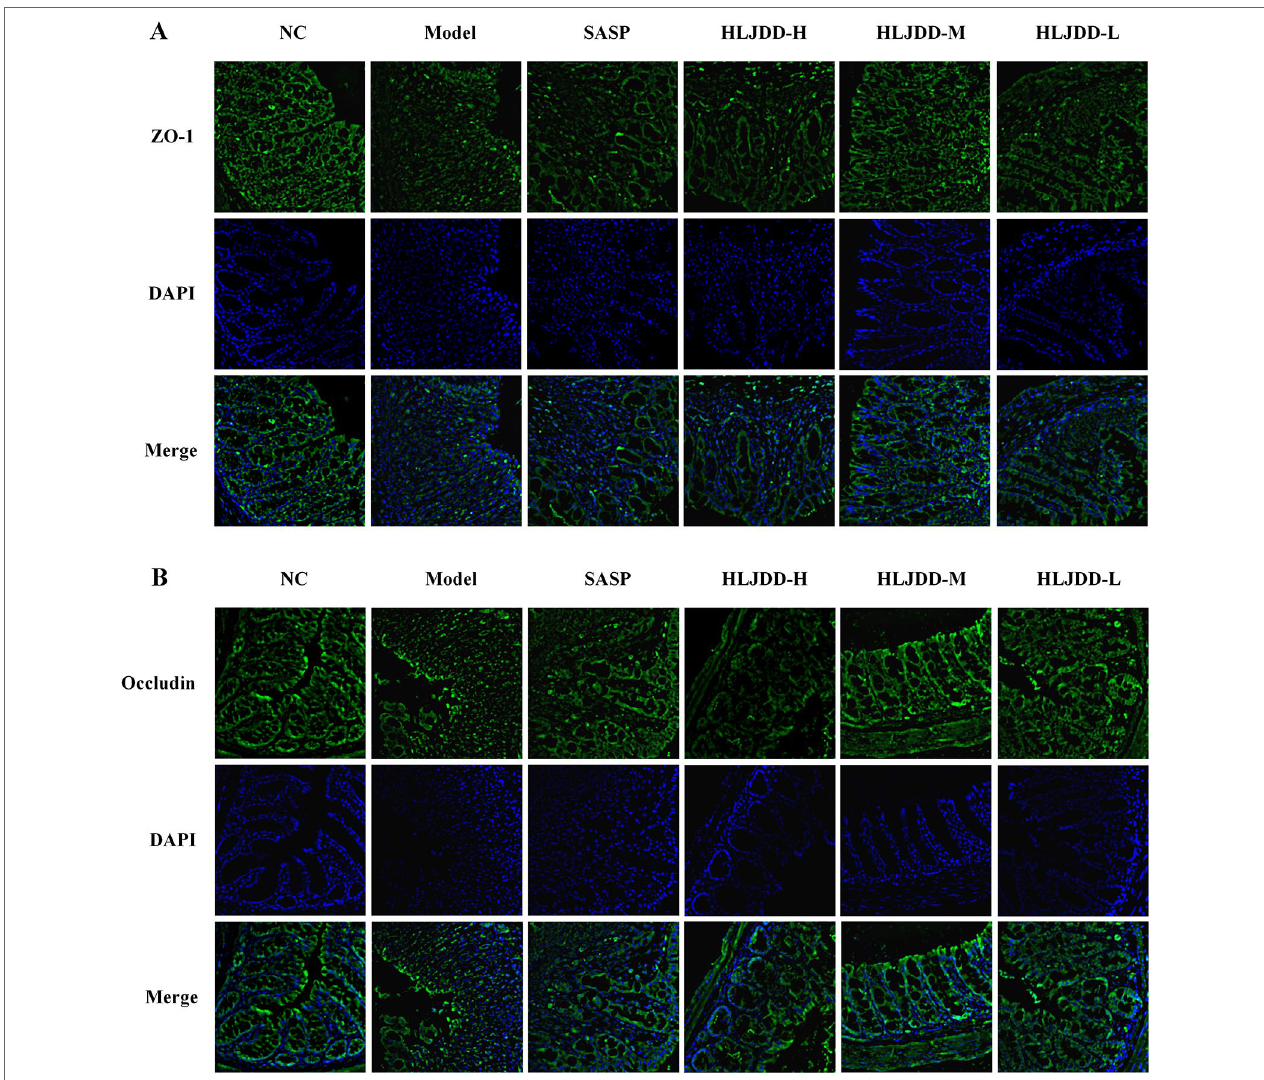
FIgURE 10 | HLJDD reduces DSS-induced destruction of tight junction proteins in colon mucosa of mice. Immunofluorescence analysis of ZO-1 (green) (A) and Occludin (green) (B) in colon mucosa (200 × magnification). DAPI was used for nuclear staining (blue). (For interpretation of the references to color in this figure legend, the reader is referred to the web version of this